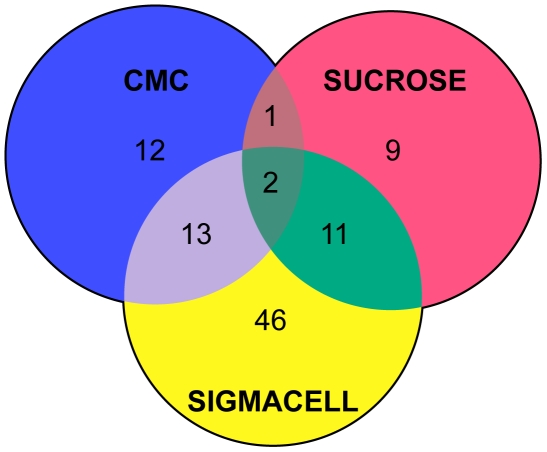
Secretome of T. turnerae.Venn diagram depicting proteins expressed during growth with indicated carbon sources. Numbers in non-overlapping regions enumerate proteins that were uniquely expressed and secreted under the indicated condition. Numbers in overlapping regions enumerate proteins expressed and secreted under multiple growth conditions.